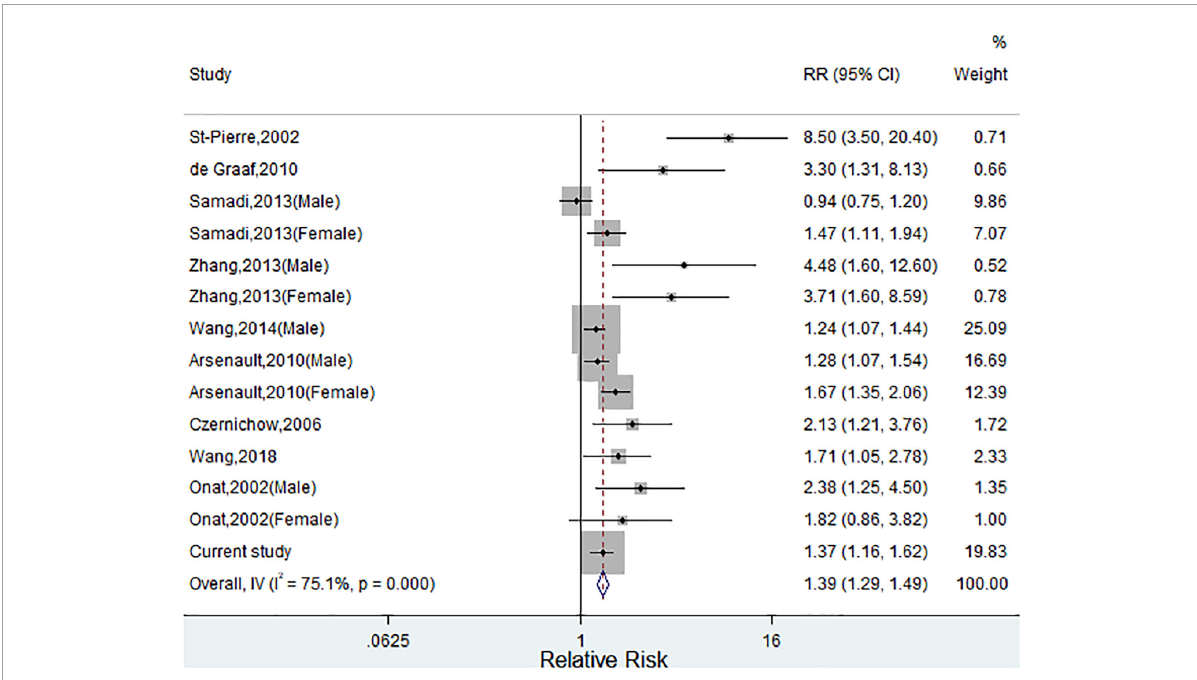
FIGURE2 Meta-analysis of relative risks (RRs) and 95% CIs for the association between hypertriglyceridemic-waist phenotype and cardiovascular disease (CVD). (Squares represent weights; Horizontal lines represent confidence intervals; Diamond represent the merging effect value; Vertical line represents the invalid